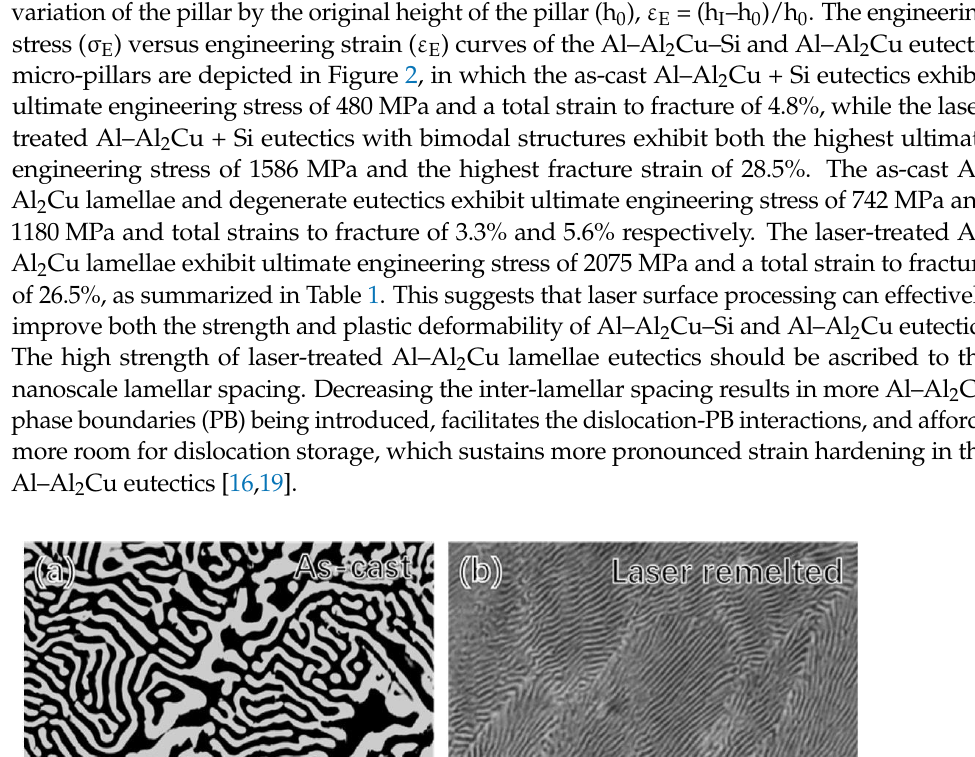
Eutectics Processing